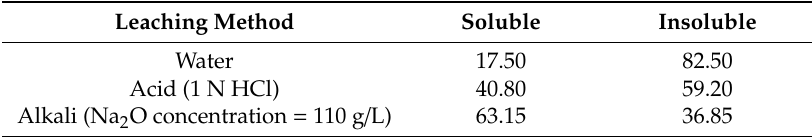
Table 2. The solubility of BCFA in deionized (DI) water, acid, and alkali (wt.%). Leaching Method Soluble Leaching method